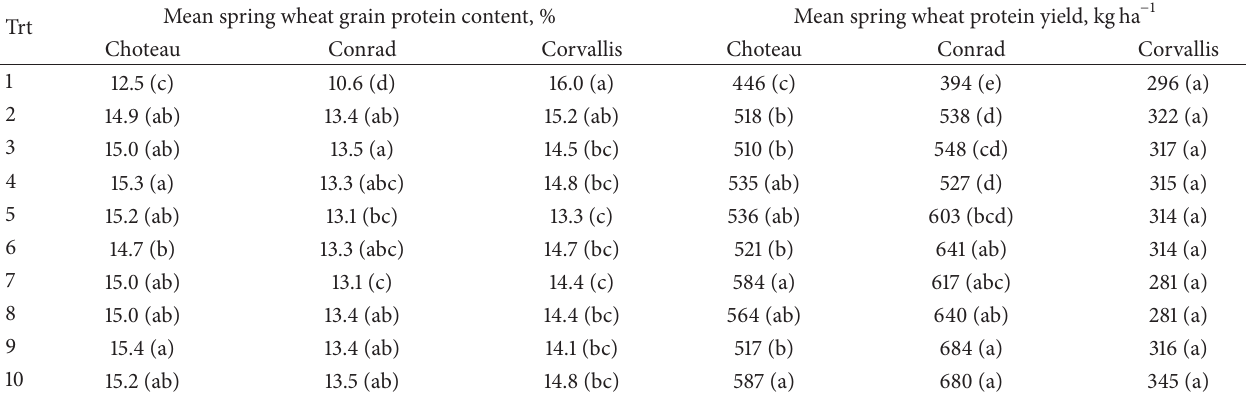
Table 6: Mean spring wheat grain protein content and protein yield, Choteau, Conrad, and Corvallis, 2013. Mean spring wheat grain protein content, % Trt